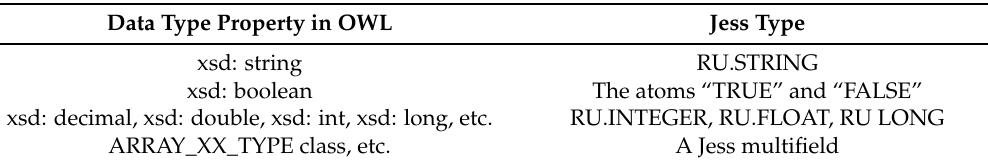
Table 4. The data type property transformation between OWL and Jess. Data Type Property in OWL Jess